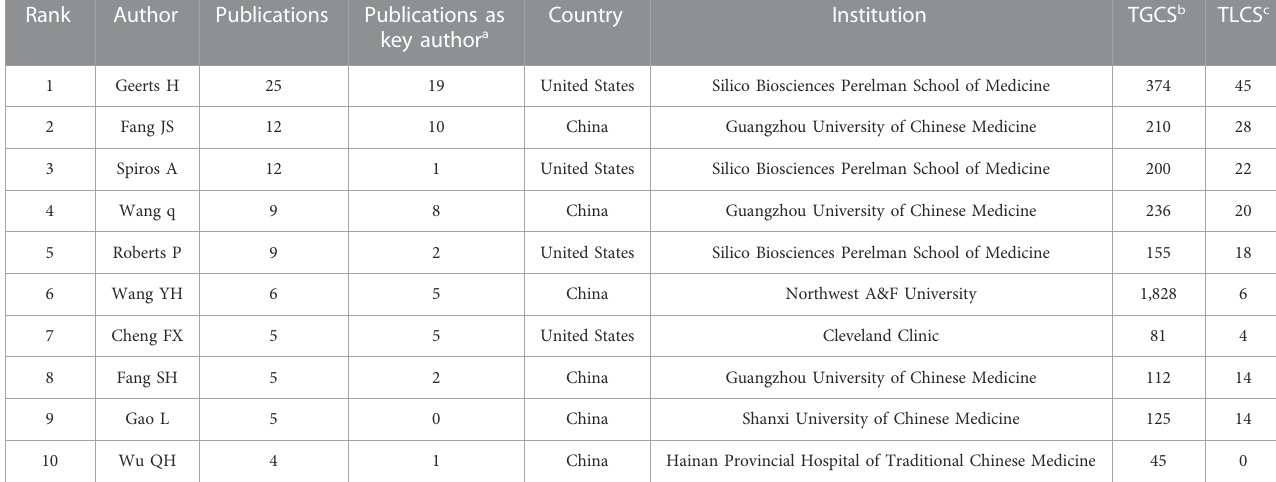
TABLE 3 Top 10 authors distributed by